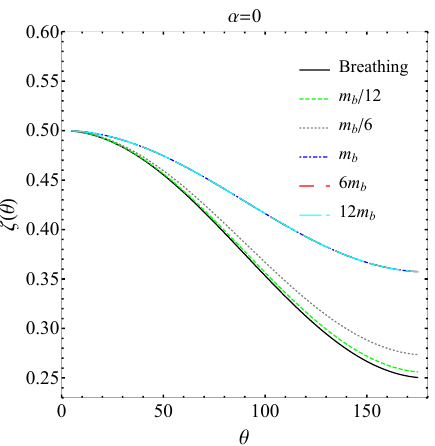
Figure 3. ζ ( θ ) v.s. m when α = 0. It is assumed that the observation takes T = 5